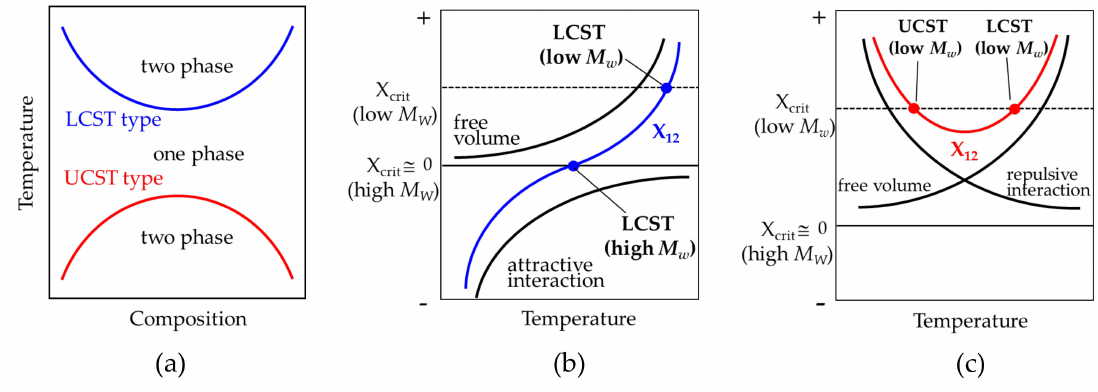
Figure 1. Schematic illustration of phase diagrams and temperature dependence of χ 12. : ( a ) LCST and UCST phase diagrams, ( b ) χ 12 for LCST type phase behavior and ( c ) χ 12 for UCST type phase